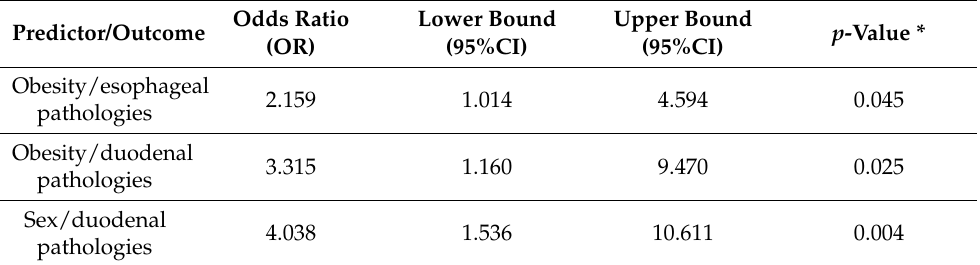
Table 6. Predictors of gastrointestinal pathologies using